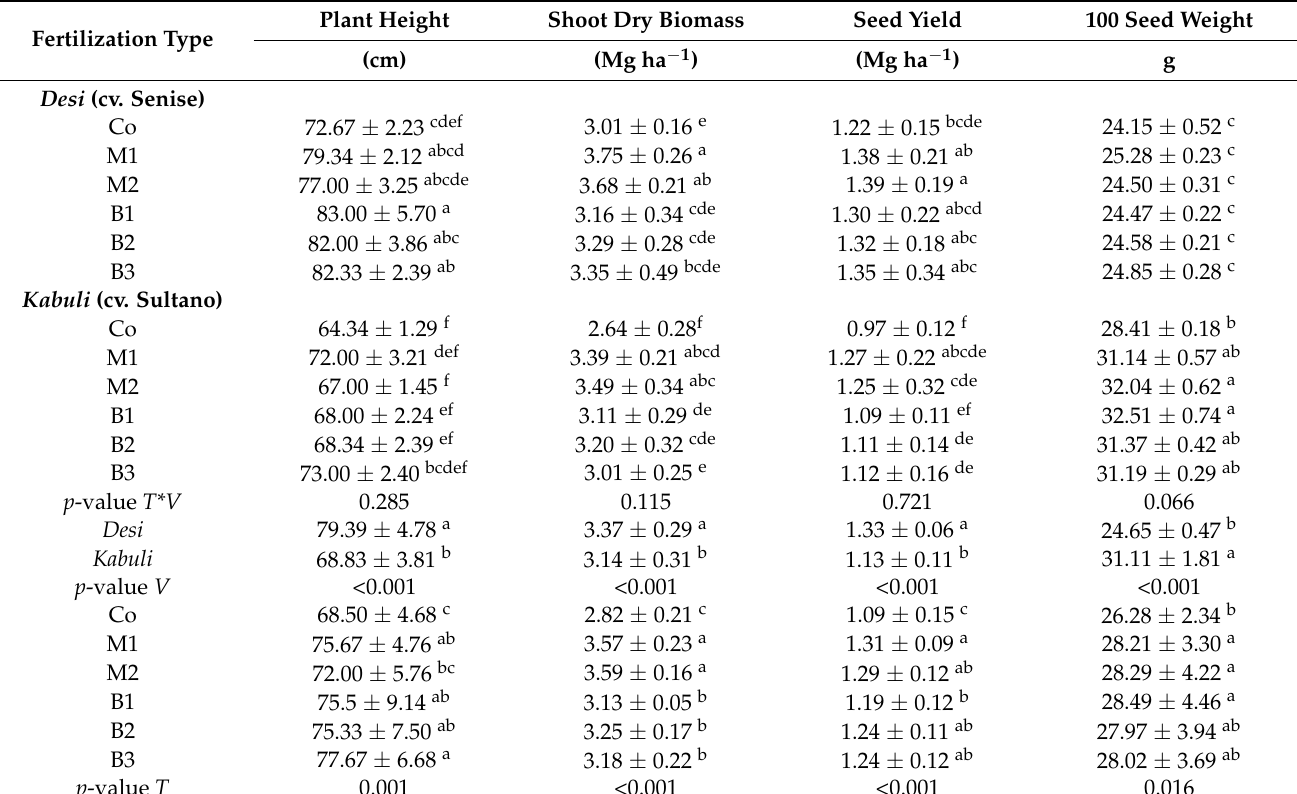
Table 1. Effect of different doses of mineral and organic fertilization on plant height and yield parameters of desi (cv. Senise) and kabuli (cv. Sultano) chickpeas (mean ± standard deviations).